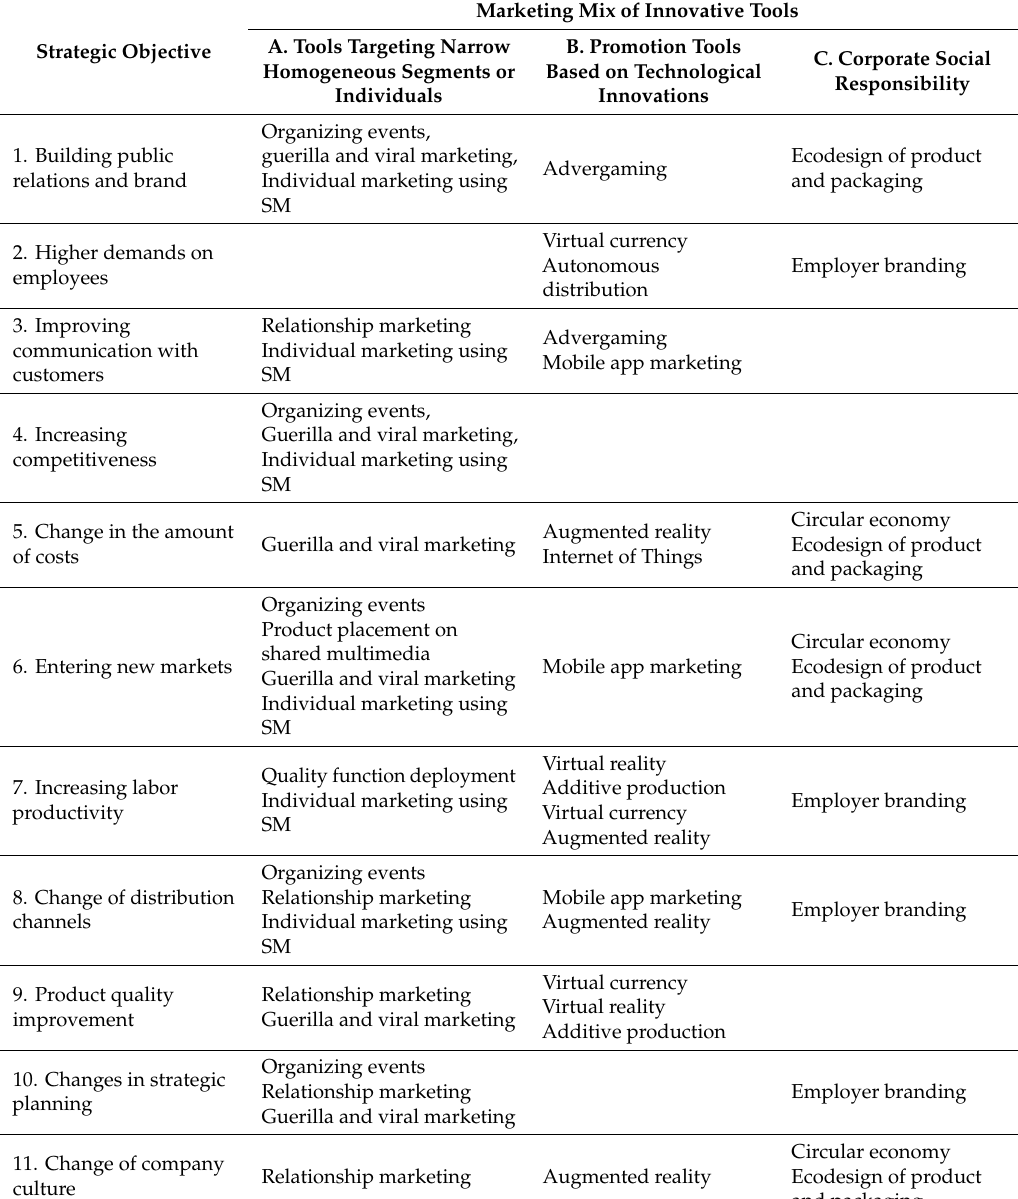
Table 4. Strategic objective and marketing mix. (SM: social